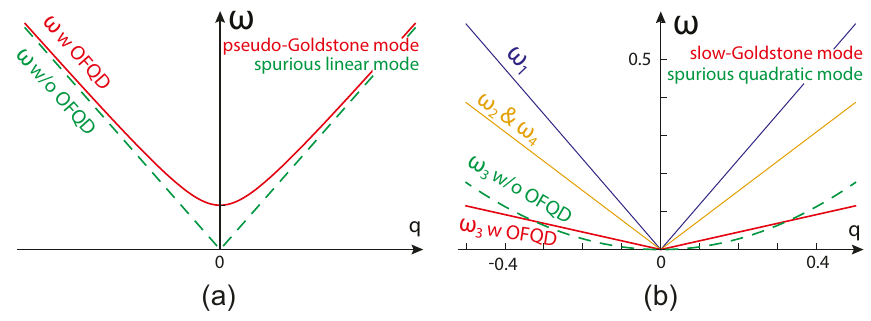
Figure 4 . The pseudo-Goldstone mode discovered in previous works vs slow-Goldstone mode discovered in this work: (a) Typical OFQD generated pseudo-Goldstone mode. The OFQD transfers a spurious linear mode ( ω w/o OFQD) into a pseudo-Goldstone mode ( ω w OFQD) with a tiny gap. (b) The OFQD generated slow-Goldstone mode ( ω 3 ) and the other 3 conventional Goldstone modes ( ω 1 , 2 , 4 ). The OFQD transfers a spurious quadratic mode ( ω 3 w/o OFQD cf. eq. (2.15)) into a slow-Goldstone mode ( ω 3 w OFQD cf. eq. (2.25)) with a very small velocity.